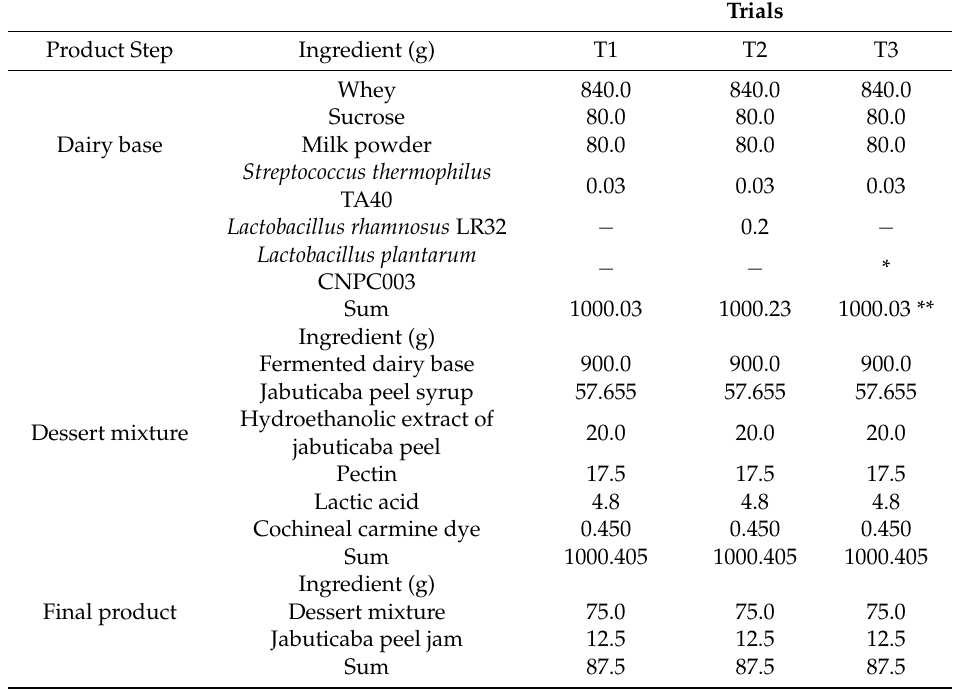
Table 1. Ingredients used to produce fermented dairy dessert of T1, T2 and T3 trials in this